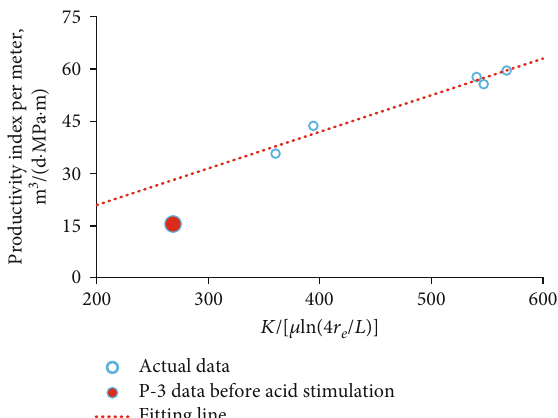
Figure 8: Productivity index per meter evaluation of P-3 before acid stimulation.